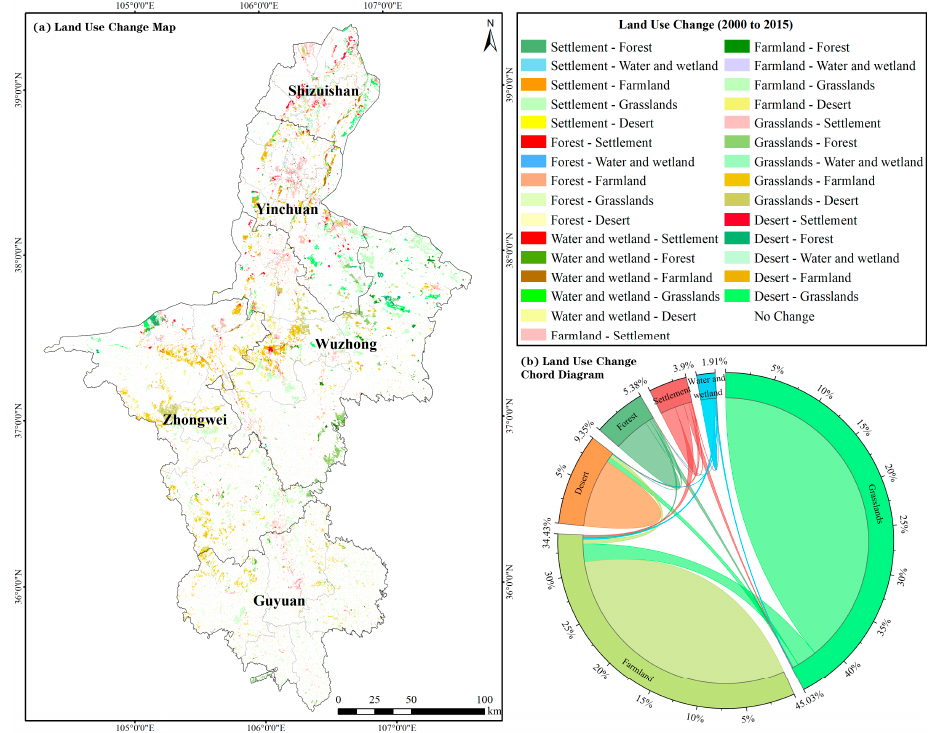
Figure 4. Spatial distribution map and chord map of land use change in Ningxia from 2000 to 2015. Table 3. Land use transfer matrix in Ningxia from 2000 to 2015 (unit: km 2 ).